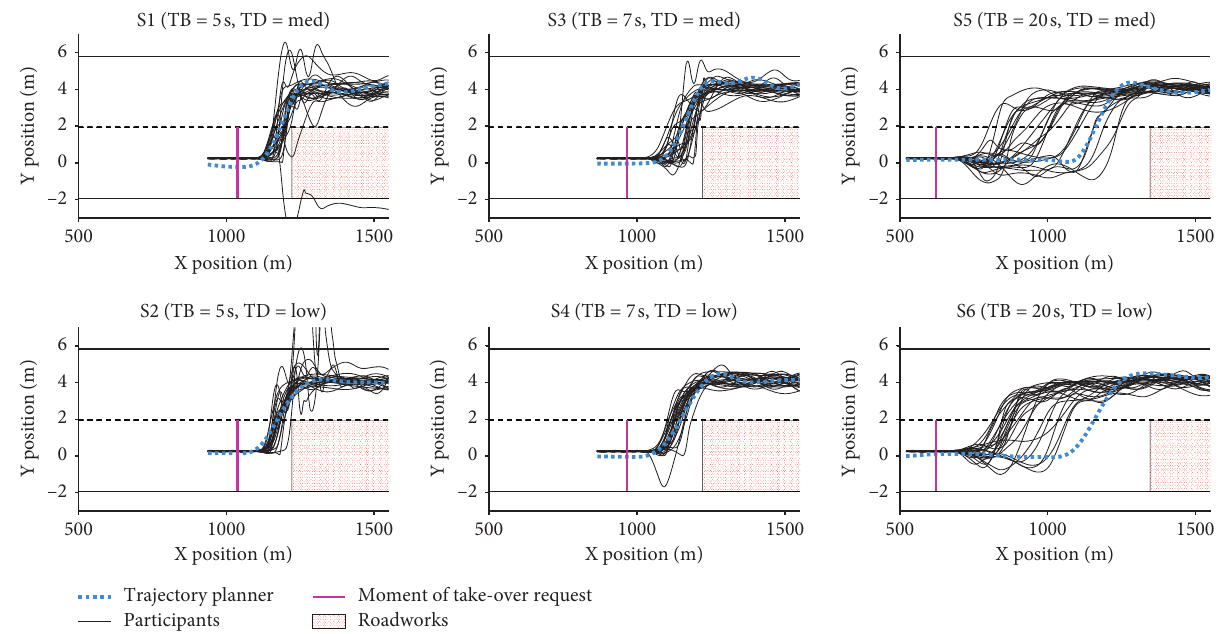
Figure 4: Trajectories of all participants in the six scenarios, including the trajectory of the trajectory planner.